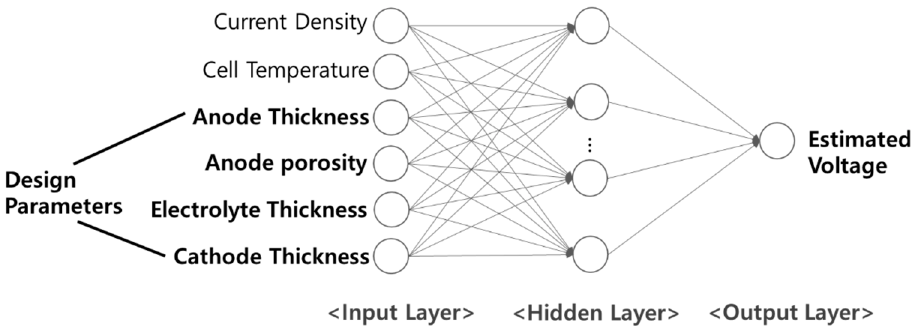
Figure 1. Artificial neural network (ANN) architecture for anode-supported solid oxide fuel cell (SOFC) model.